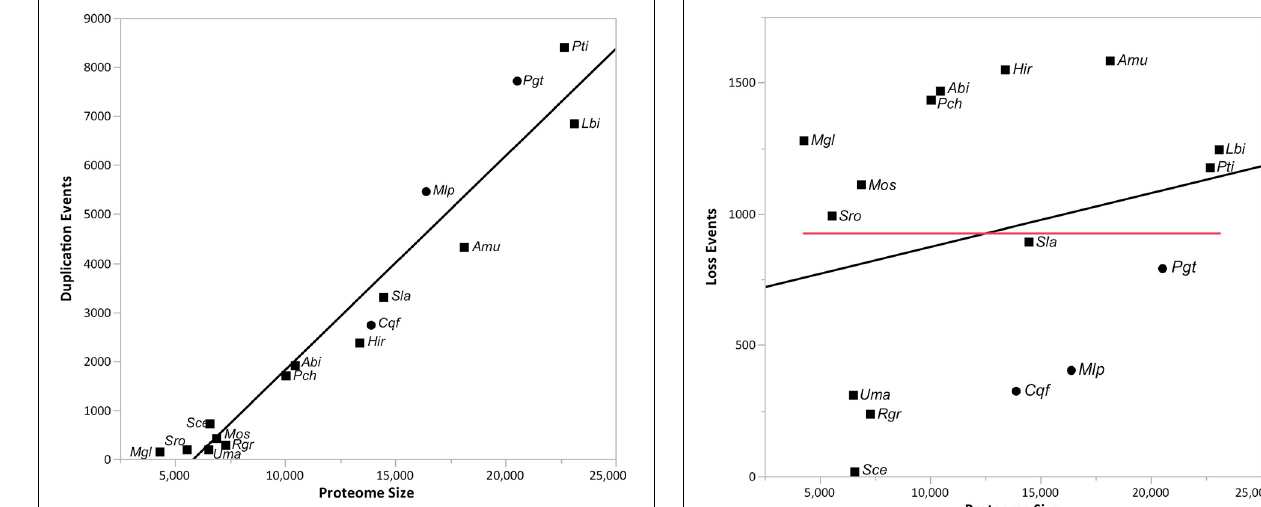
FIGURE 5 | Lack of relationship between proteome size and gene family losses across taxa. The relationship ( R 2 = 0 . 06) between the proteome size (i.e., protein count) and the number of species-specific losses detected in the analyses from Figure 1 is depicted in this figure. The line of best fit (black) and fit mean (red) are also shown. Rust pathogens ( Cqf , Mlp , and Pgt ) are indicated with circles and non-rust pathogens with squares. Please reference Methods for species